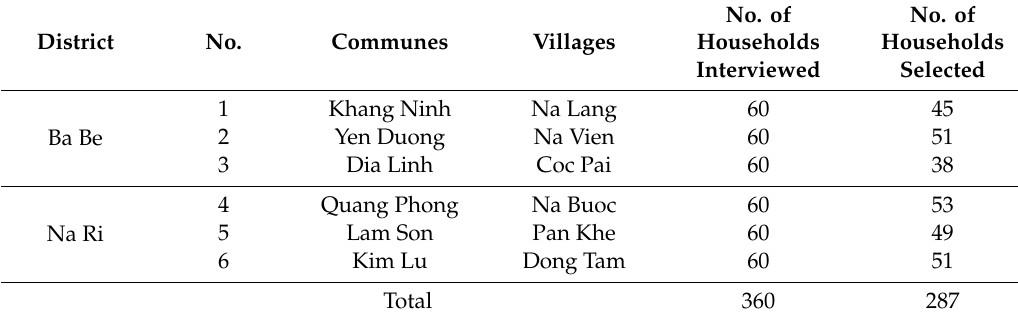
Table 1. Village selection and